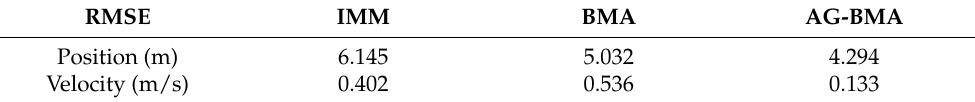
Table 2. Average root-mean-square error corresponding to the three algorithms.